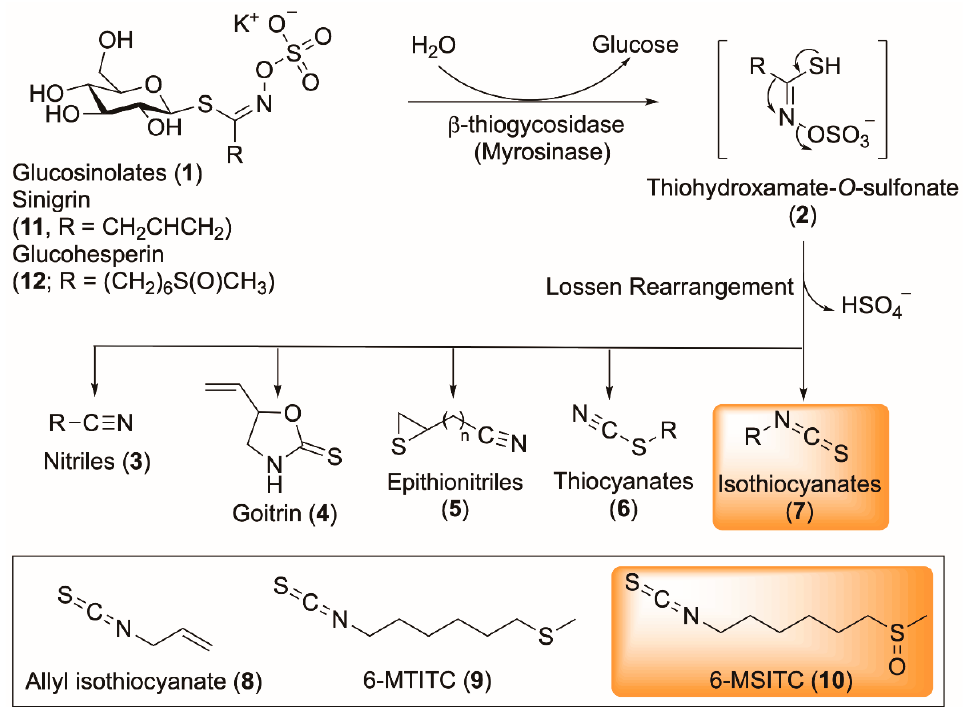
Figure 1. Myrosinase-catalysed hydrolysis of wasabi glucosinolates.